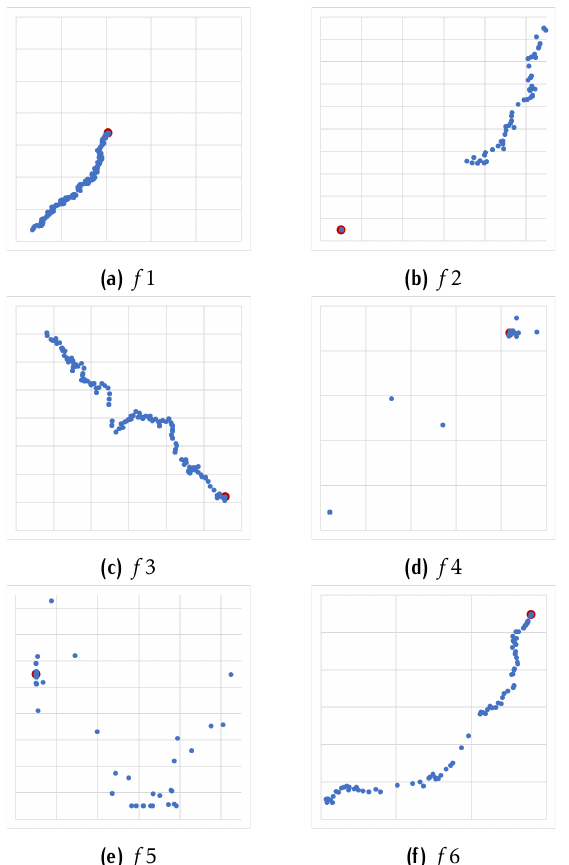
Figure 4. Trajectory of the best firefly with crossover with annealing with the best K